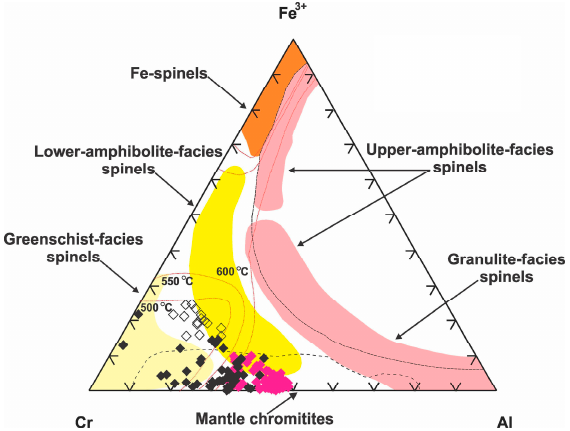
Figure 17. Compositional changes in spinel phases from the examined chromitites expressed in a triangular Al-Fe 3+ -Cr diagram with special reference to the fields of the different metamorphic facies defined for Cr-spinels by [89–91]. Solvus determined at 600, 550 and 500 °C by [88] for Cr-spinel coexisting with forsteritic olivine (Fo 90 ). Explanation of symbols as in Figure 11.